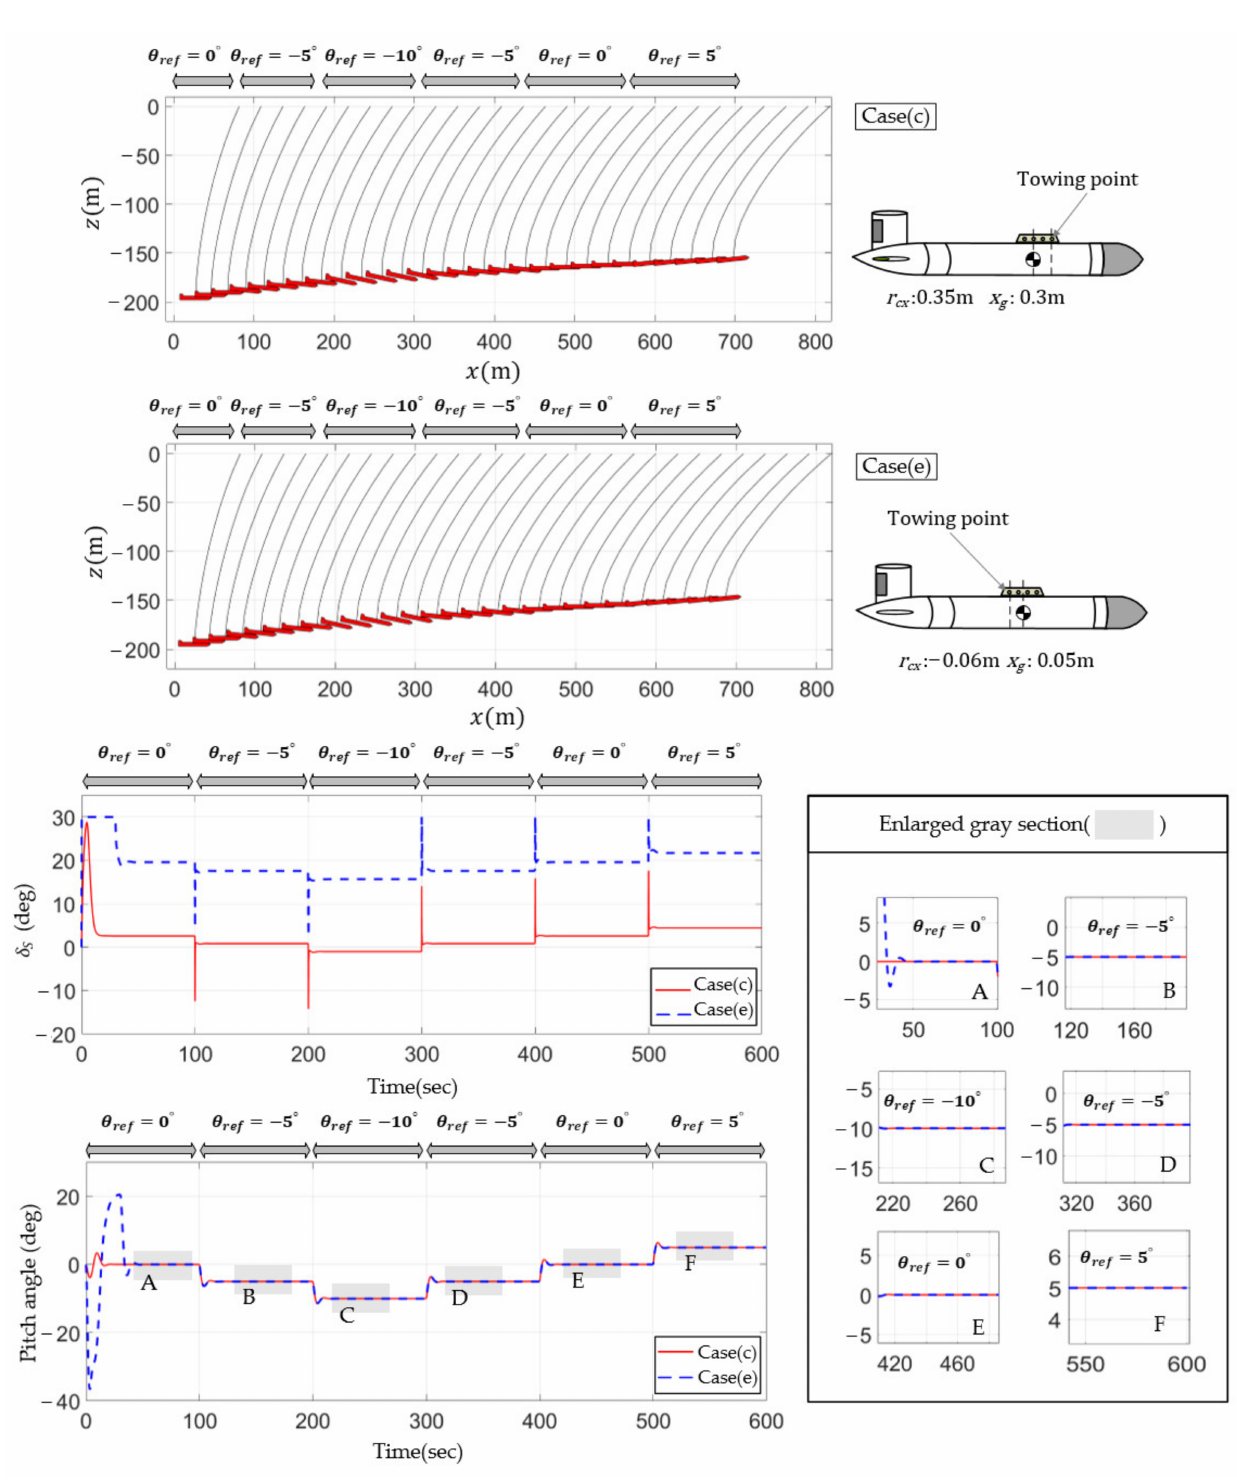
Figure 11. Simulation results when pitch control is applied for Cases (c) and (e). Here, δ s = ( δ r + δ l )